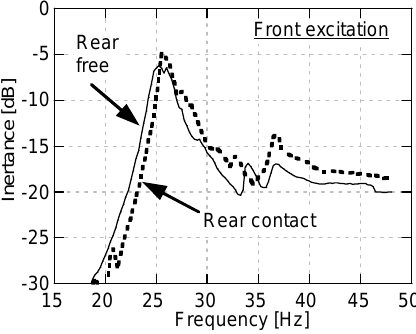
Fig. 5. Inertance of measurement point P on the handlebars, lateral direction ( y )